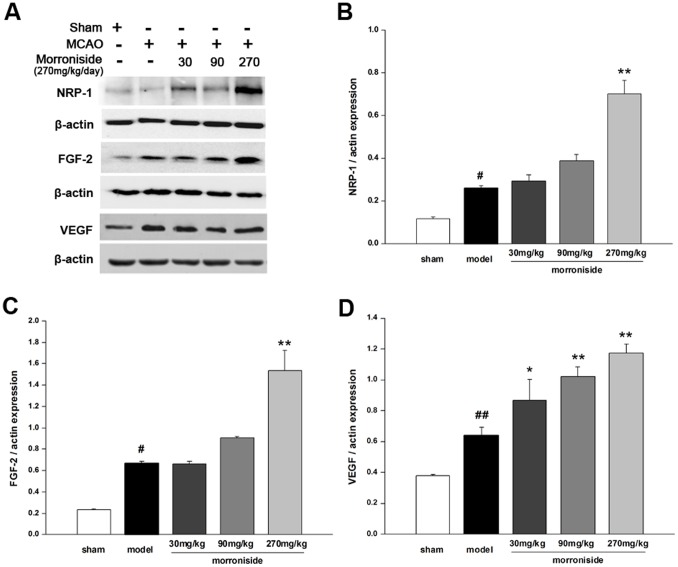
Effects of morroniside on the expression of angiogenic factors in the ischemic cortex of rats 7 days after cerebral ischemia.(A) Representative images of immunoblot analysis of NRP-1 (120 kDa), FGF-2 (20 kDa) and VEGF (25 kDa) in the ischemic ipsilateral cortex 7 days after MCAO. (B-D) Quantitative analysis of NRP-1 (B), FGF-2 (C) and VEGF (D) expressed as a fraction of the respective levels of β-actin. n = 3 for each group. The values are the mean ± SEM. #
p<0.05 and ##
p<0.01 versus sham-operated control group; *p<0.05 and **p<0.01 versus vehicle-treated ischemic group.